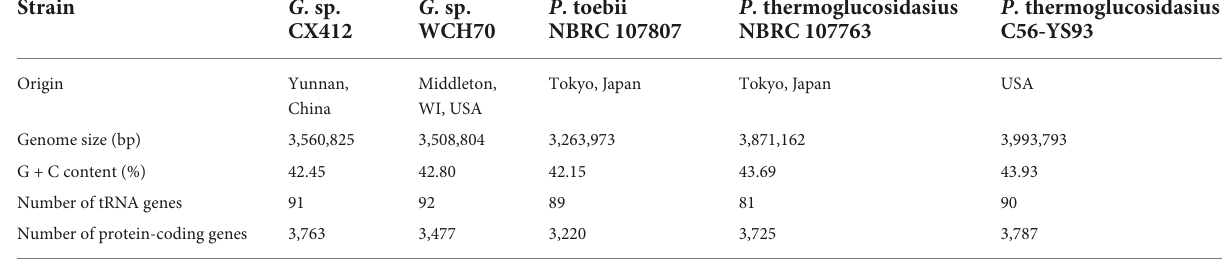
TABLE 2 Genome statistics of representative thermophilic Geobacillus and Parageobacillus . Strain